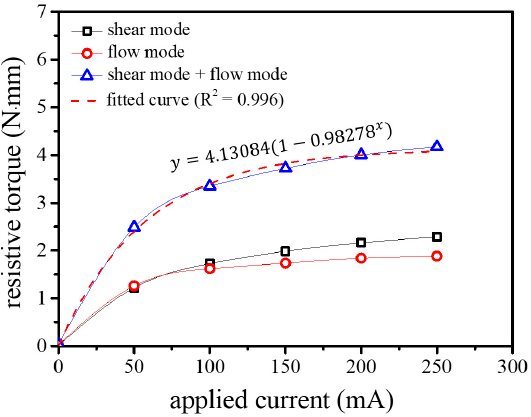
Figure 7. Calculated resistive torque by the applied current and its fitted curve.